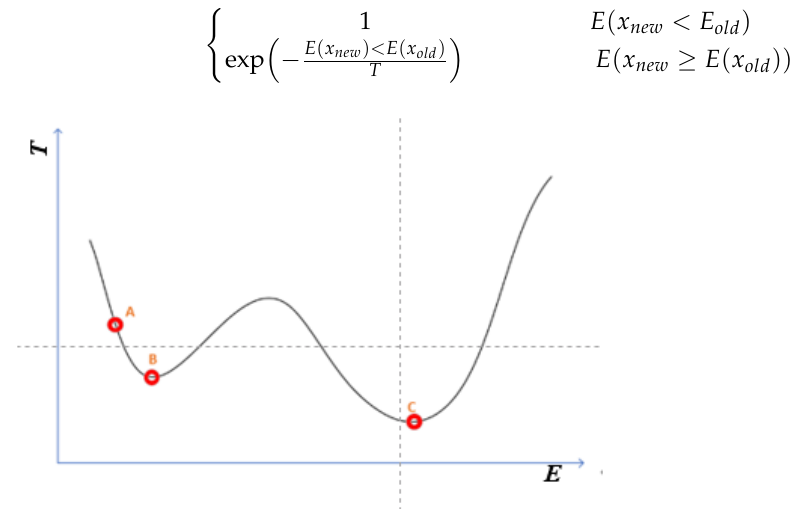
Figure 5. Simulated annealing algorithm to find the optimal value (the lowest point). Algorithm 4. Simulated Annealing algorithm.